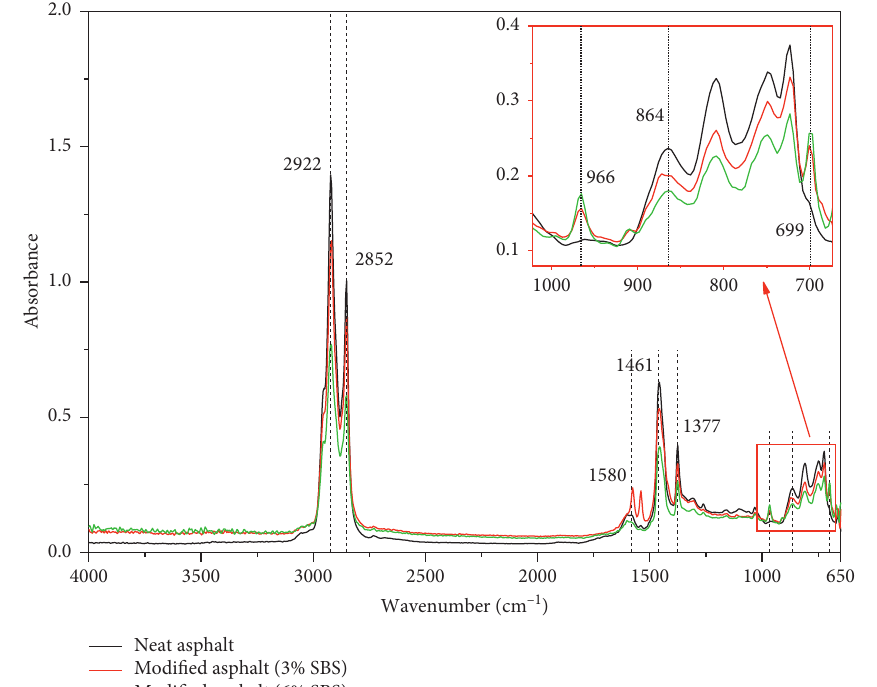
Figure 3: FTIR test.